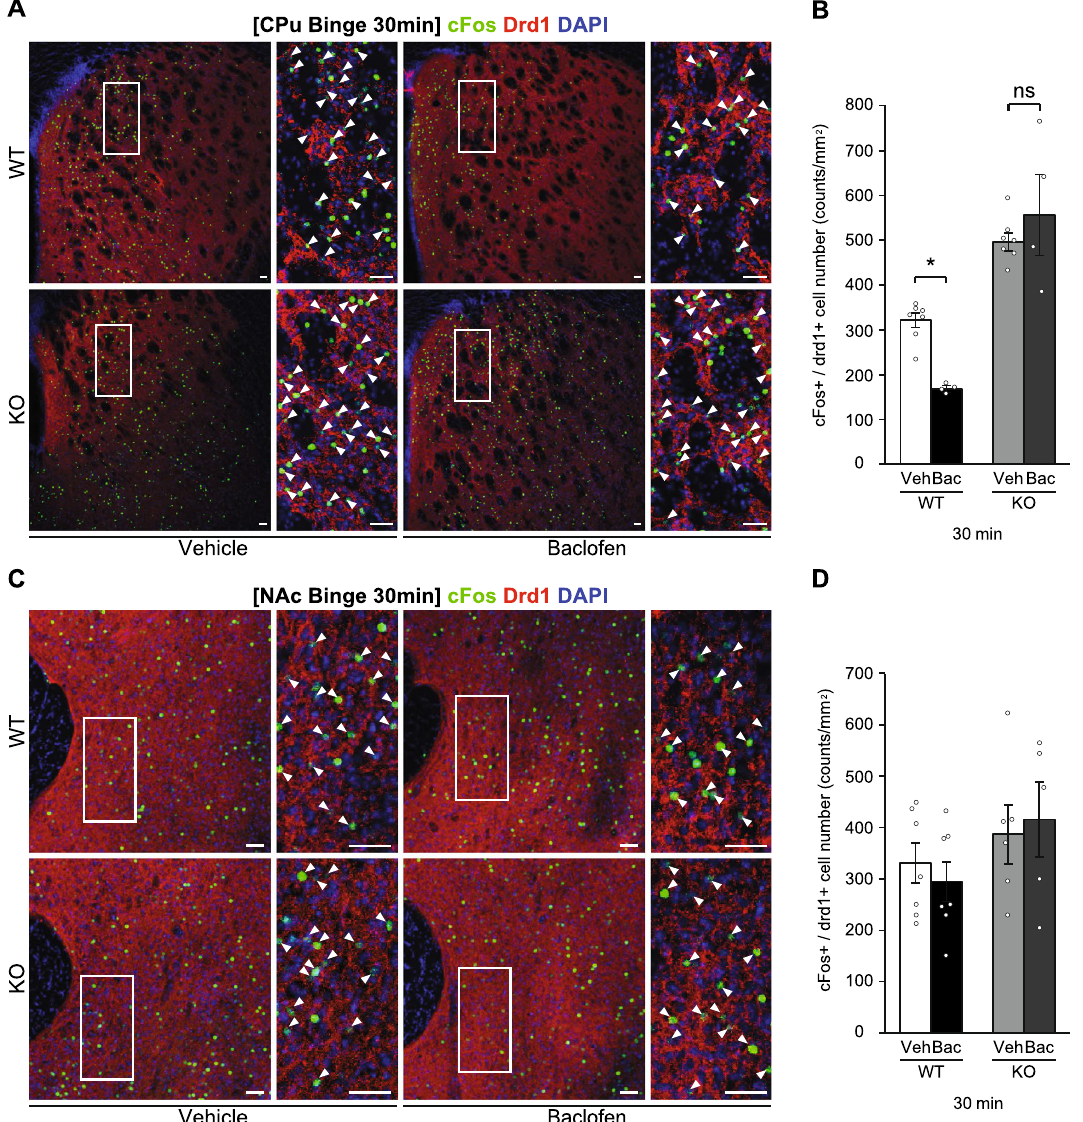
(red), and DAPI (blue) in the caudate putamen (CPu) ( A ) and nucleus accumbens (NAc) ( C ) of wild-type (WT) and knockout (KO) mice at 30 min on a high fat diet (HFD) in the binge group. White arrowheads show the colocalization of cFos and drd1. Scale bars: 50 μm. ( B and D ) cFos-positive cells in drd1-positive neurons (cFos + /drd1 +) in the CPu ( B ) and NAc ( D ) of WT and KO mice at 30 min on a HFD in the binge group. All values are mean ± SEM. Statistical analyses were performed using two-way factorial analysis of variance (ANOVA) followed by Sidak’s post-hoc test ( B and D ). ns: not significant, veh: vehicle, bac: baclofen. * p < 0.05 versus vehicle in WT mice. See also Supplemental Table 2 for details on